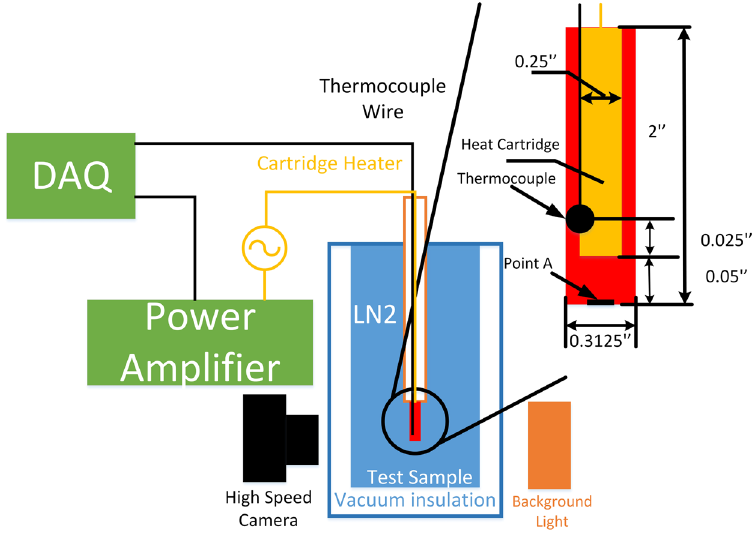
Figure 11. Schematic of experimental system.